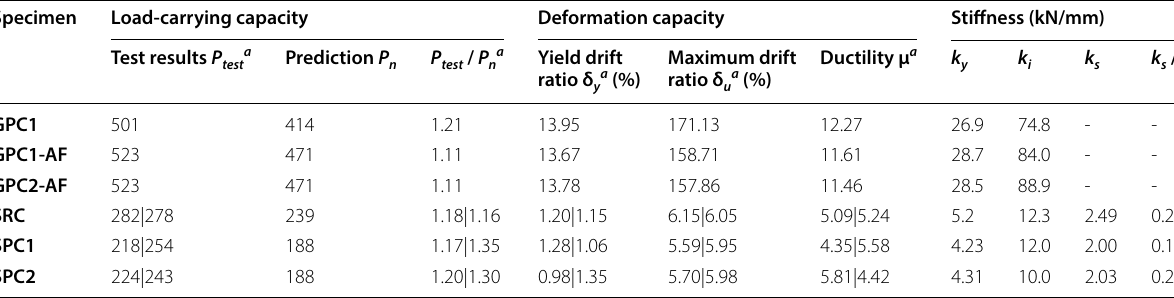
Table 3 Summary of test results and